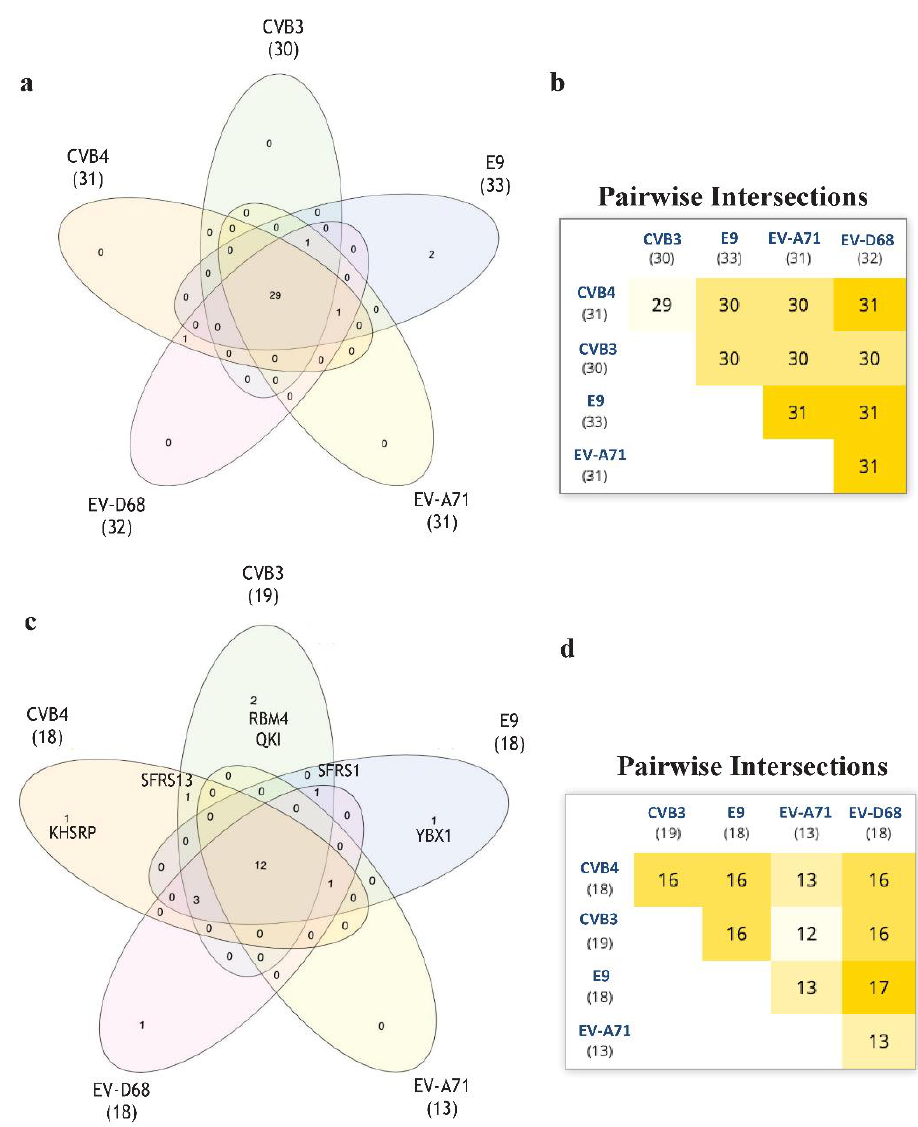
Figure 6. The RNA-binding motif analyzed via RBPDB approach. ( a ): Venn diagram representation for all the motifs present in the input sequences with similarity ≥ 80%. ( b ): Related pairwise inter- section. ( c , d ): Venn diagram visualization and pairwise intersection of filtered motifs from the same analysis of ( a ) and ( b ), setting thefilter to obtain only motifs with 100% sequence similarity with the database used.